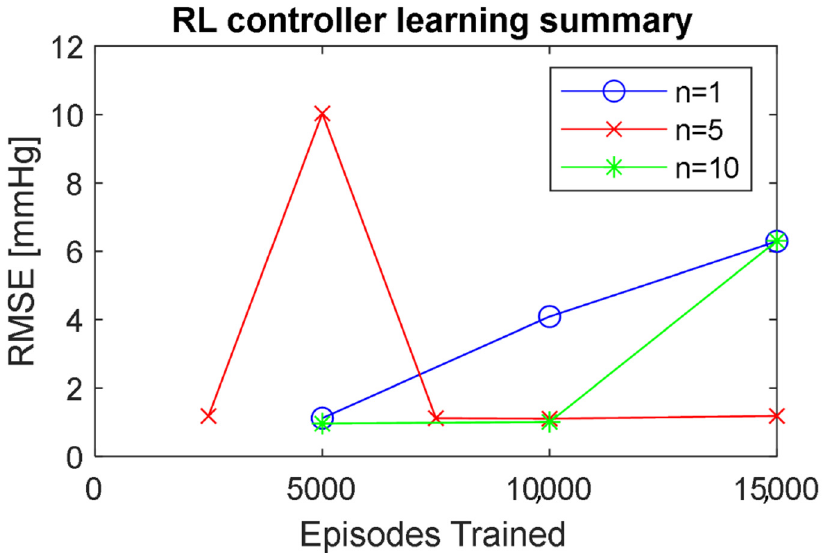
Figure 4. Results of the RL controller training for n = 1, 5, and 10. The agents with n = 1 and 10 showed diverging behavior.